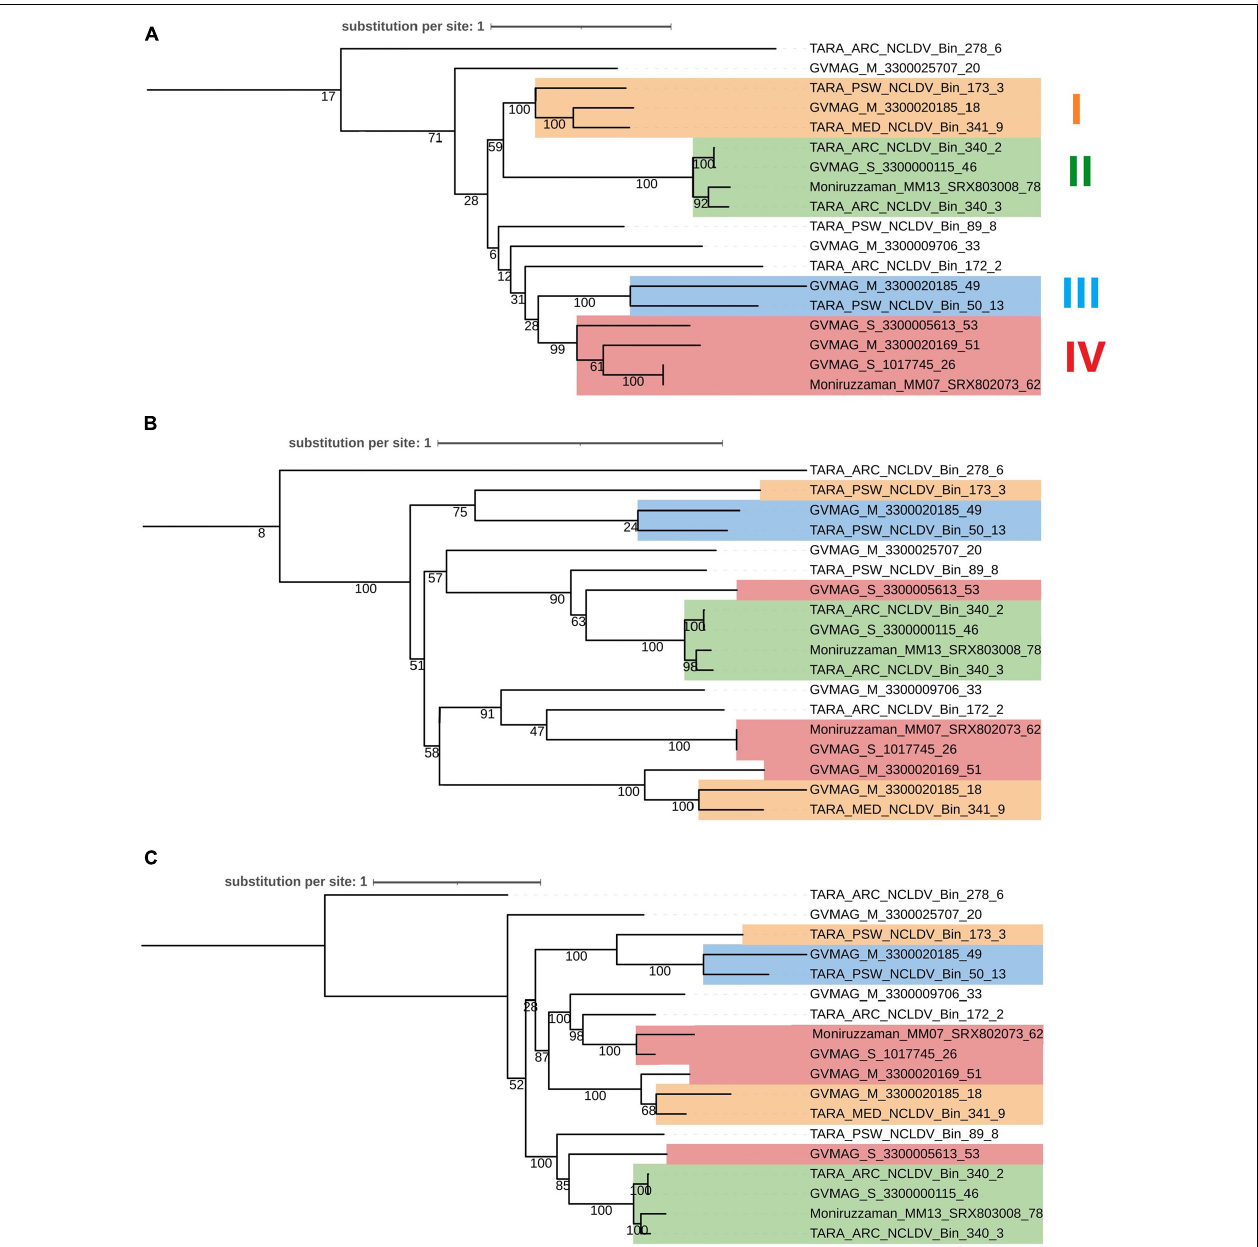
FIGURE 6 | Phylogenetic trees of (A) viral myosins, (B) PolBs, and (C) core gene sequences from MAGs encoding both genes myosin and PolB. Labels at the leaves are the identifiers of the NCLDV MAGs. Clades supported with a parametric bootstrap value > 99% in the myosin tree are marked in both trees by colored rectangles. This myosin and PolB trees were generated from Figure 3 and Figure 2 by extracting MAGs encoding both myosin and PolB, respectively. Clades I–IV correspond to highly supported groups in the myosin